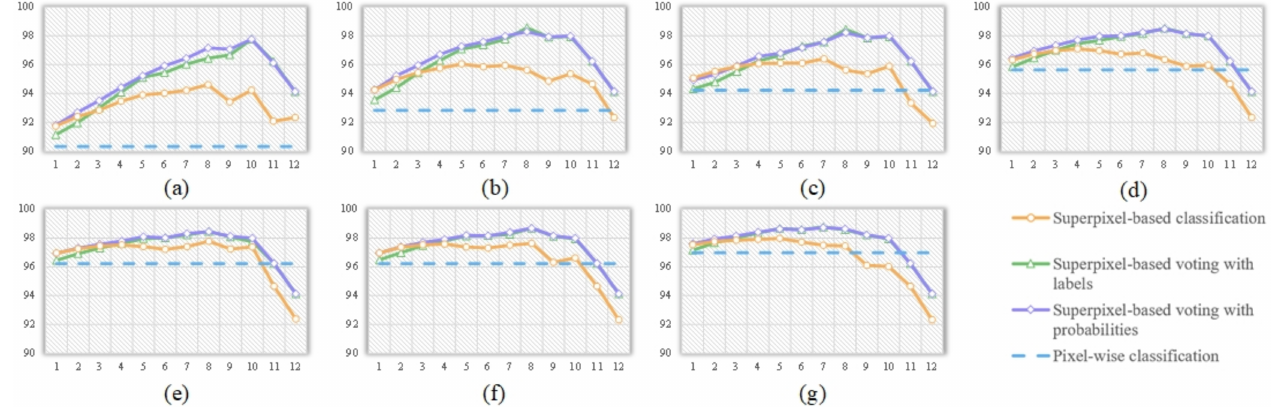
Figure 5. Accuracies given by the single-scale approaches with ( a ) 25, ( b ) 50, ( c ) 100, ( d ) 150, ( e ) 200, ( f ) 250, and ( g ) 300 training samples per class for the Longkou dataset using SVM, where the vertical axis represents the OAs, and the horizontal axis represents the superpixel segmentation scale.